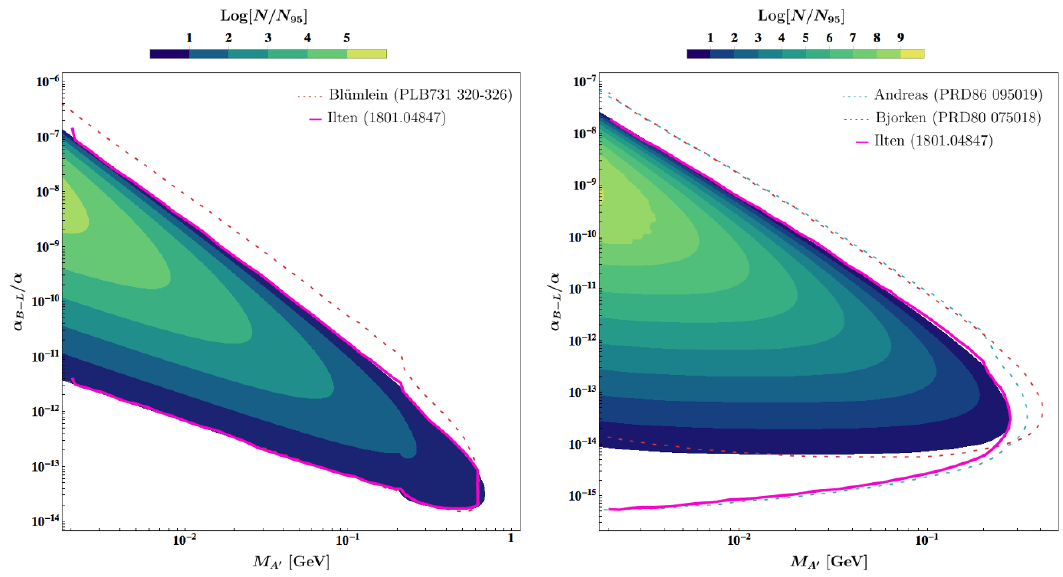
Comparison of beam bump limits for the U(1) B L gauge boson calculated in this (cid:0) work to the recasted limits of [10]. The calculated limits are given by the border of the outermost blue contour. The recasted limits are depicted by the pink solid line. NuCal (left): the red dashed line shows the respective limit for the secluded hidden photon. E137 (right): the red and cyan dashed lines show the respective limits for the secluded hidden photons discussed